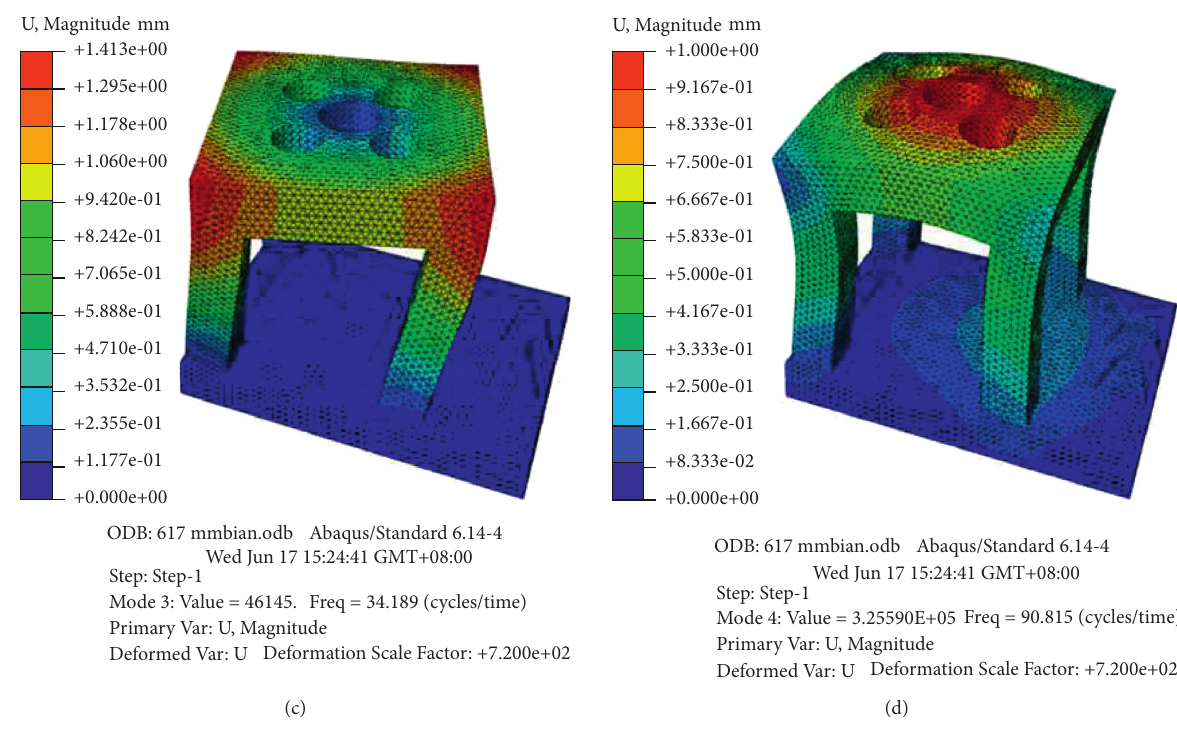
Figure 8: Modal analysis results of compression-shear test machine frame before optimization. (a) First-order mode. (b) Second-order mode. (c) Third-order mode. (d) Fourth-order